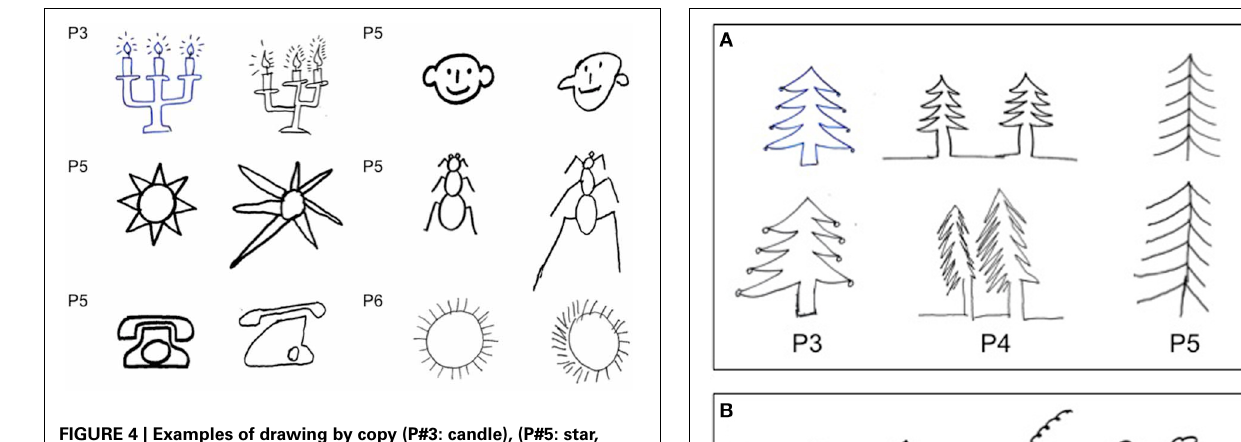
rectangle was longer), were given a positive score. Leftward errors